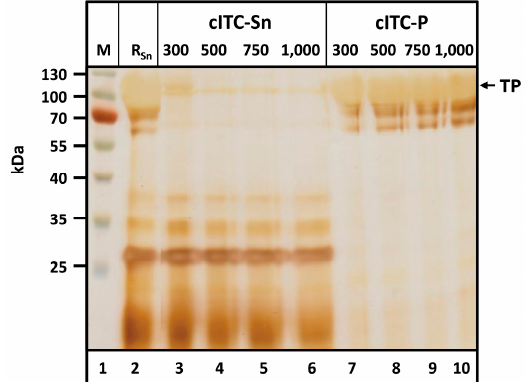
Figure 5. Polishing of Q-MaSp1-100× ELP by centrifugation-based Inverse Transition Cycling (cITC). A washed and lyophilized pellet resulting from fractionating acetone precipitation was resolubilized in 6 M urea and centrifuged. The supernatant (lane 2) was aliquoted and dialyzed against buffers containing 50 mM Tris-HCl (pH 8.0) and NaCl ranging from 300–1000 mM. Samples were then heated to 40 °C and centrifuged. The target protein (TP) was concentrated in the pellet (cITC-P), while soluble contaminants remained in the supernatant (cITC-Sn). M-Prestained protein ladder; R Sn -soluble fraction of resolubilized pellet after precipitation with 70% ( v / v ) acetone. The arrow indicates the molecular size of the target protein (TP).